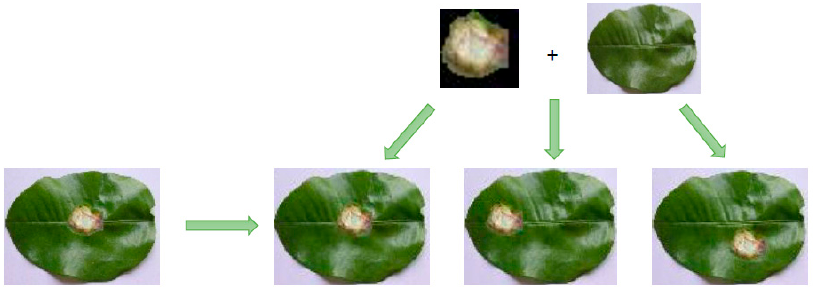
Figure 6. Comparison of images before and after edges were smoothed. Lesions were placed at different locations on the leaves.